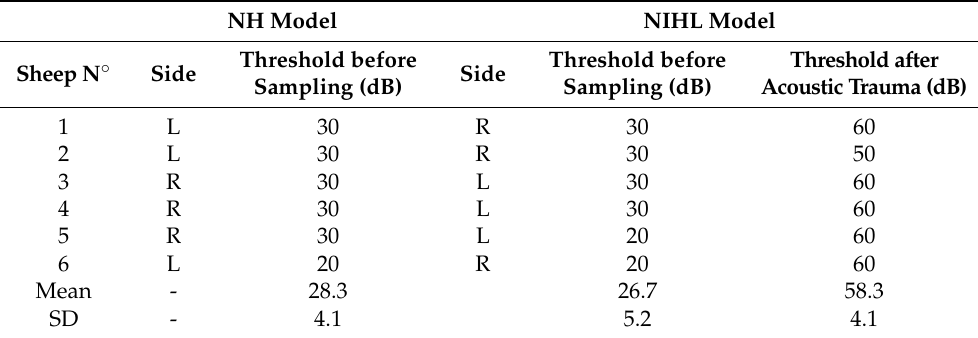
Table 2. Auditory thresholds (wave IV from BC-ABRs) for the NH model ear before perilymph sampling, and for the NIHL model ear before perilymph sampling and after acoustic trauma. NH Model NIHL Model Sheep N